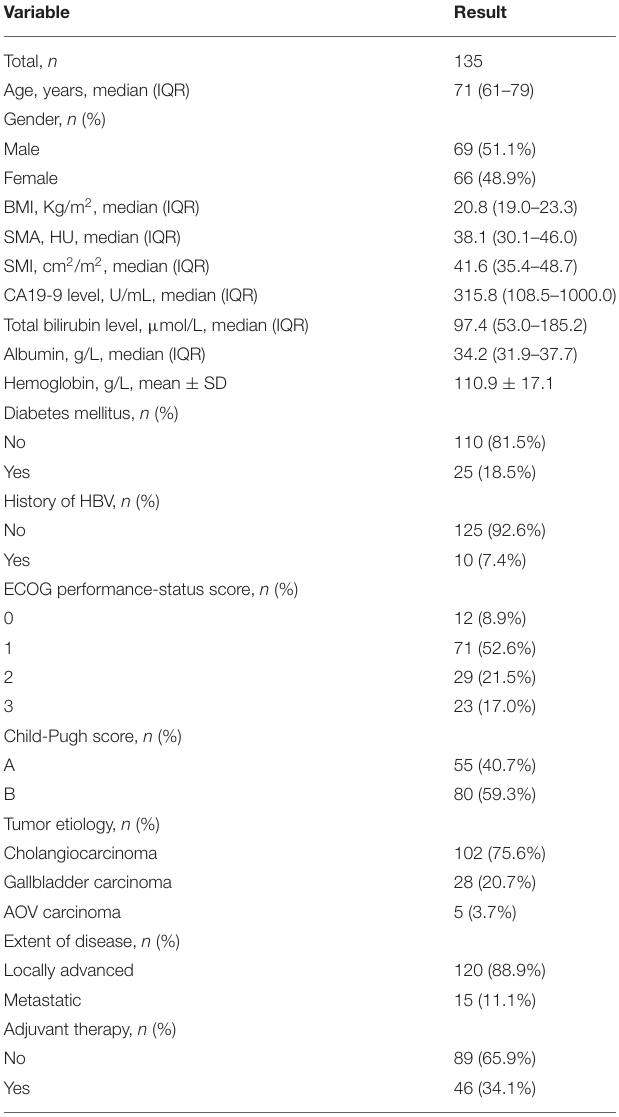
TABLE 1 | Baseline characteristics of included